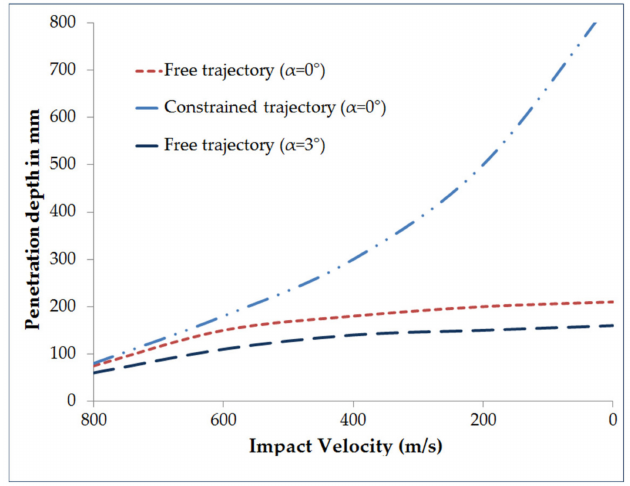
Figure 4. Variation of penetration depth with projectile impact velocity in cohesionless soil, projectile trajectory (with and without rotation of projectile), and yaw angle ( α